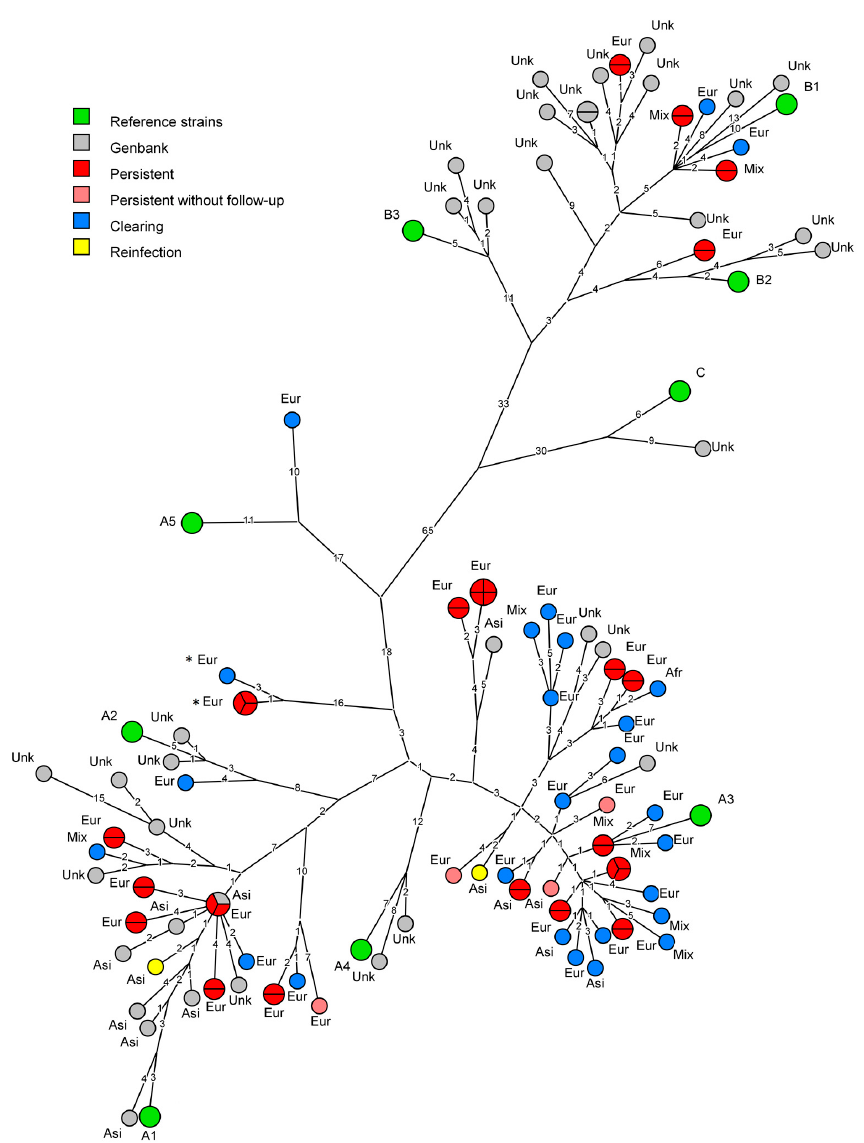
Figure 2. Maximum parsimony phylogenetic tree representing obtained human papillomavirus (HPV) 18 sequence data with corresponding ethnicity and compared to the currently available sequences in Genbank. Numbers on branches indicate the number of nucleotide differences between variants. Each circle represents one sequenced HPV18 variant, with the parts showing how often a variant was found. In green are reference strains for HPV18 according to [4]. Red and pink circles represent sequences obtained from persisting infections with and without sequenced follow-up respectively. Blue circles represent sequences obtained from clearing infections. The yellow circles show an infection where the initial and follow-up samples from one participant cluster differently. Grey circles represent sequences obtained from Genbank. Ethnicity for these sequences was added if available or presented as “Unk” (unknown) if not available. Marked with * are two variants who clustered poorly with any reference strain, but are still closest to A3.